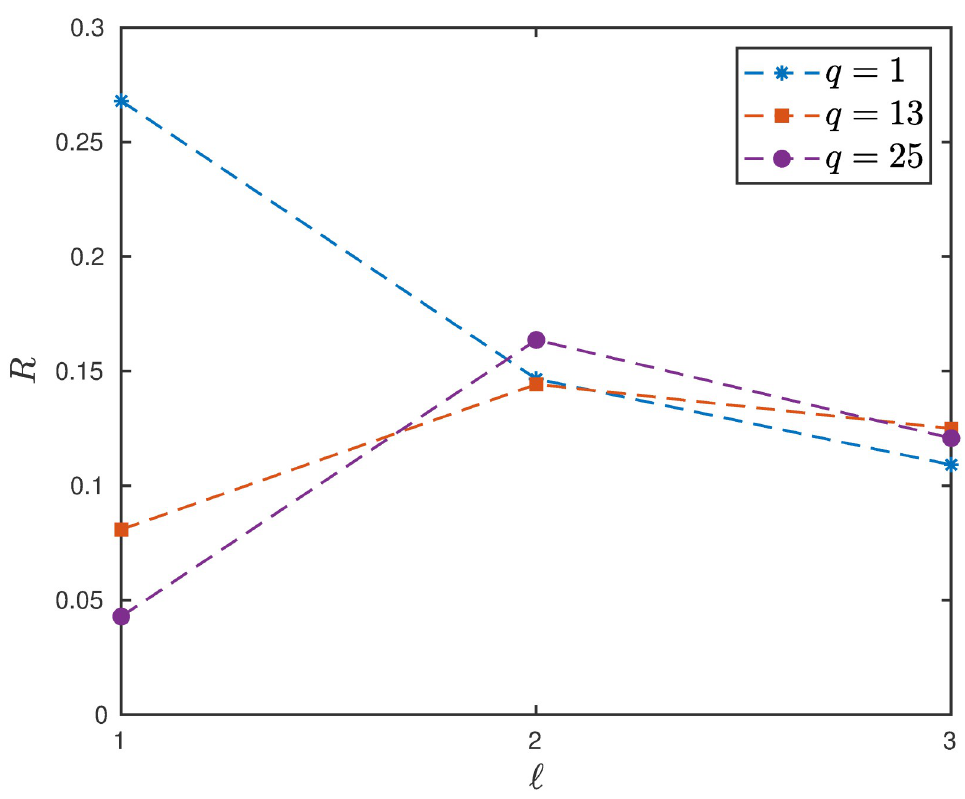
Fig 6. The steady-state output rate R as a function of ℓ 2 {1, 2, 3} for a EFEIOD with n = 9, λ 0 = 1, λ i = 1, α i = 0, for all i and r = 1/ q .